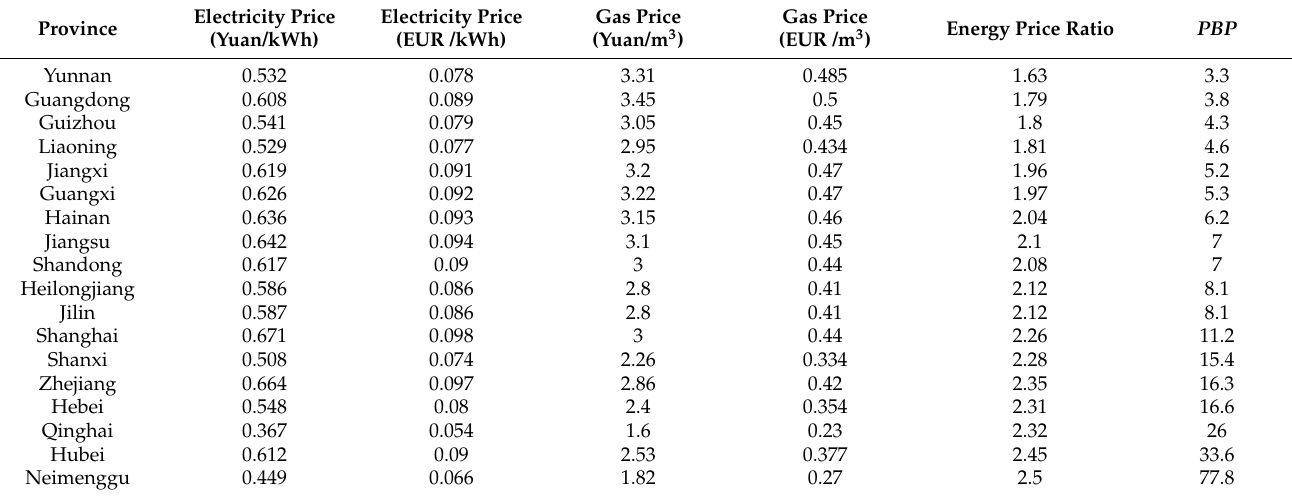
Table 4. PBP for HTCHP industrial application in different provinces in China.